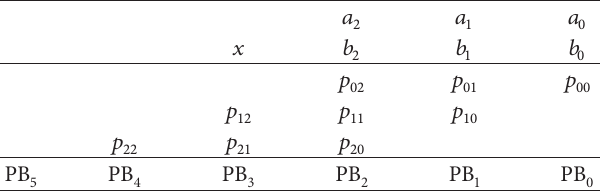
Table 1: A 3-bit by 3-bit binary